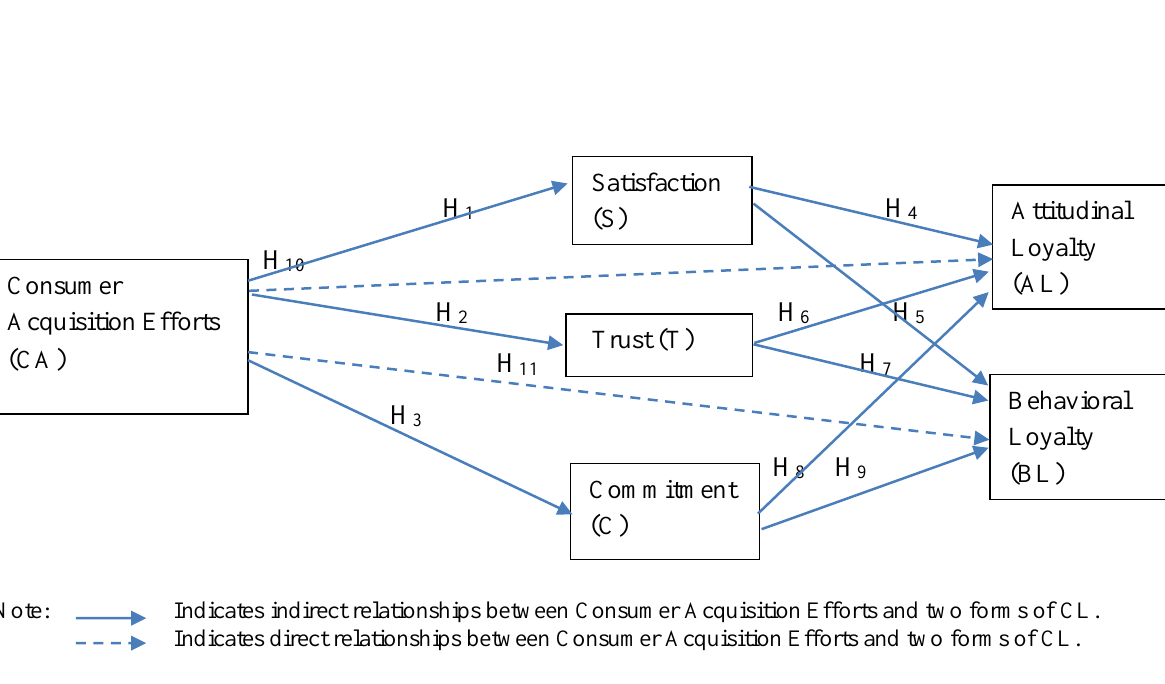
Figure 01: Proposed Theoretical Model with